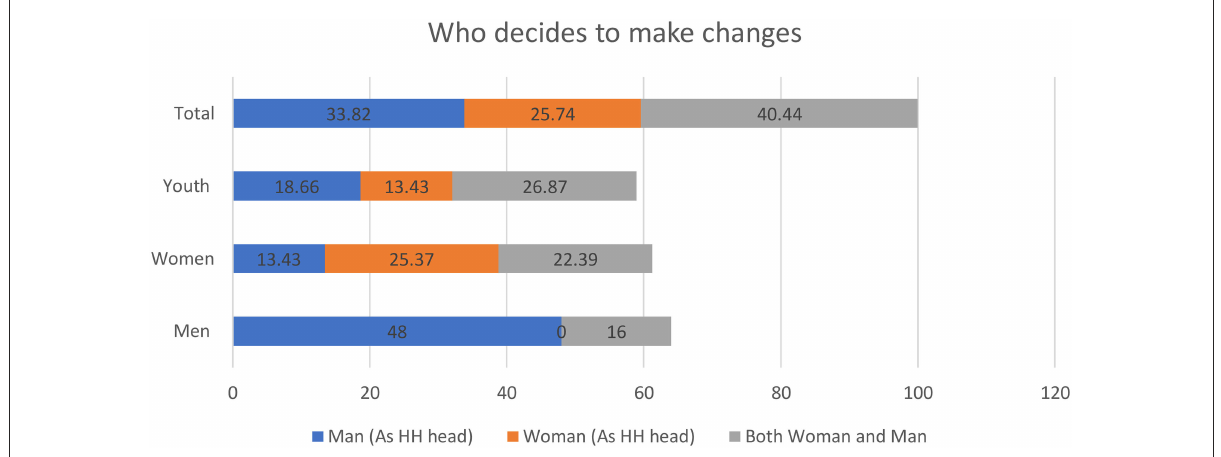
FIGURE1 Decision-maker about changes to protect bean production against production constraints by